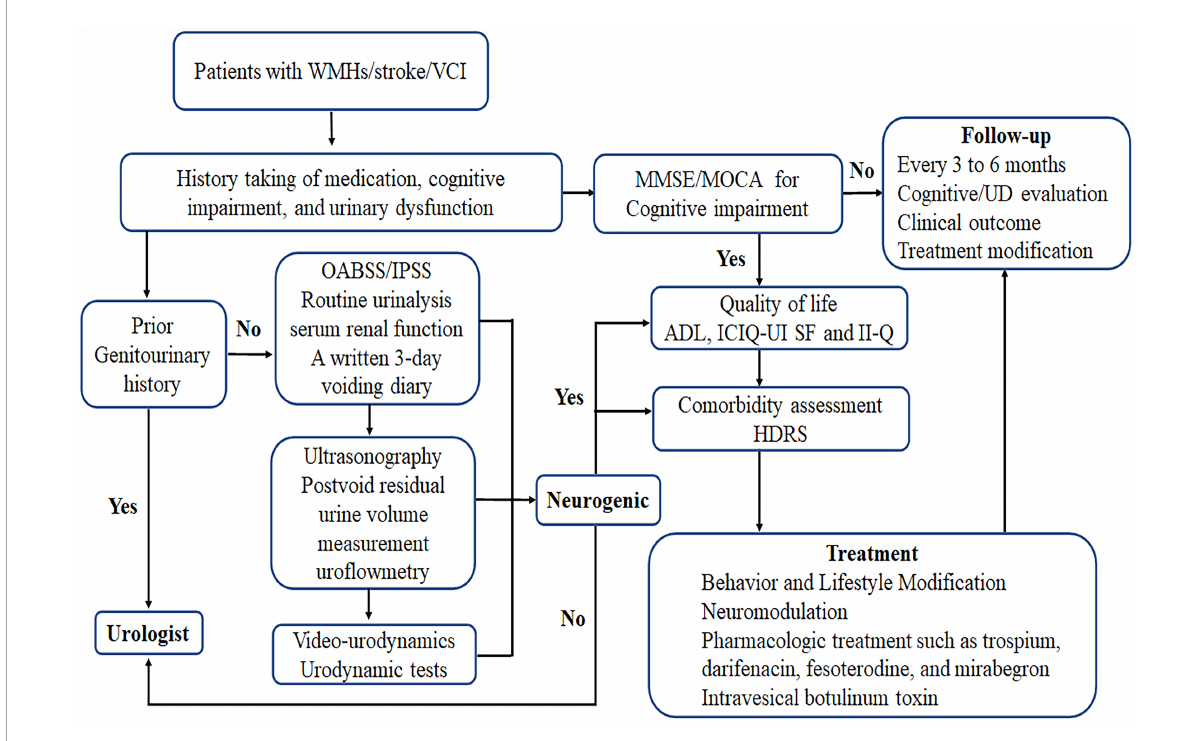
FIGURE3 Assessment and treatment process and detection and evaluation process. OABSS, overactive bladder symptom score; IPSS, International Prostate Symptom Score; HDRS, Hamilton Depression Rating Scale; ADL, Activities Of Daily Living scale; ICIQ-UI SF, International Consultation on Incontinence Questionnaire-Urinary Incontinence Short Form; II-Q, Incontinence Impact Questionnaire; MMSE, Mini-Mental State Examination; MOCA, Montreal Cognitive Assessment; WMHs, white matter hyperintensities; UD, urinary dysfunction; VCI, vascular cognitive